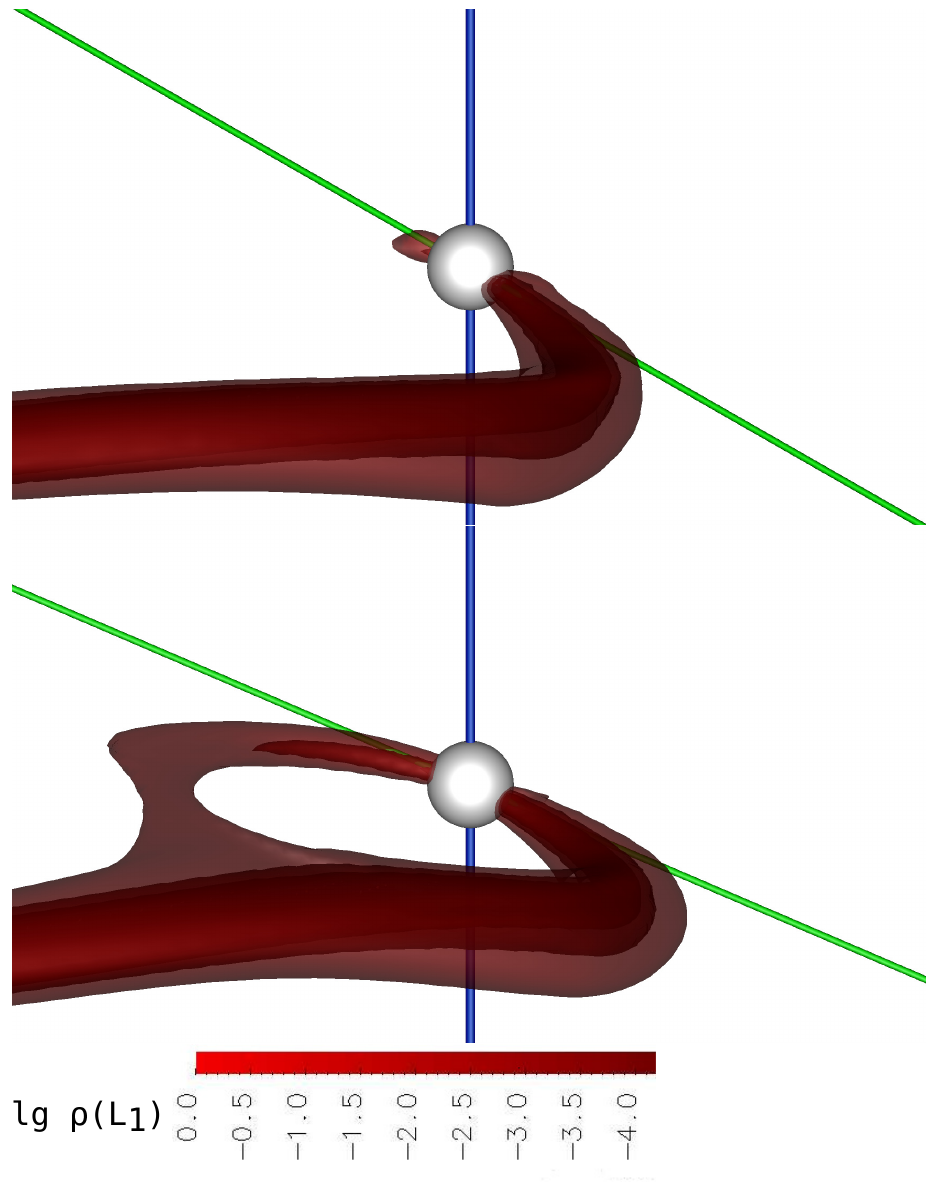
Figure 6. The result of three-dimensional numerical modeling of the structure of the flow matter in the asynchronous polar with the non-offset dipole for the moment of switching from the south magnetic pole to the north. The iso-surfaces of the decimal logarithm of the density are shown in units of ρ ( L 1 ) . The surface of the accretor is represented as a white sphere. The binary system is at the orbital phase 0.9. The upper panel corresponds to Phase 1, and the lower one corresponds to Phase 2 of the switching